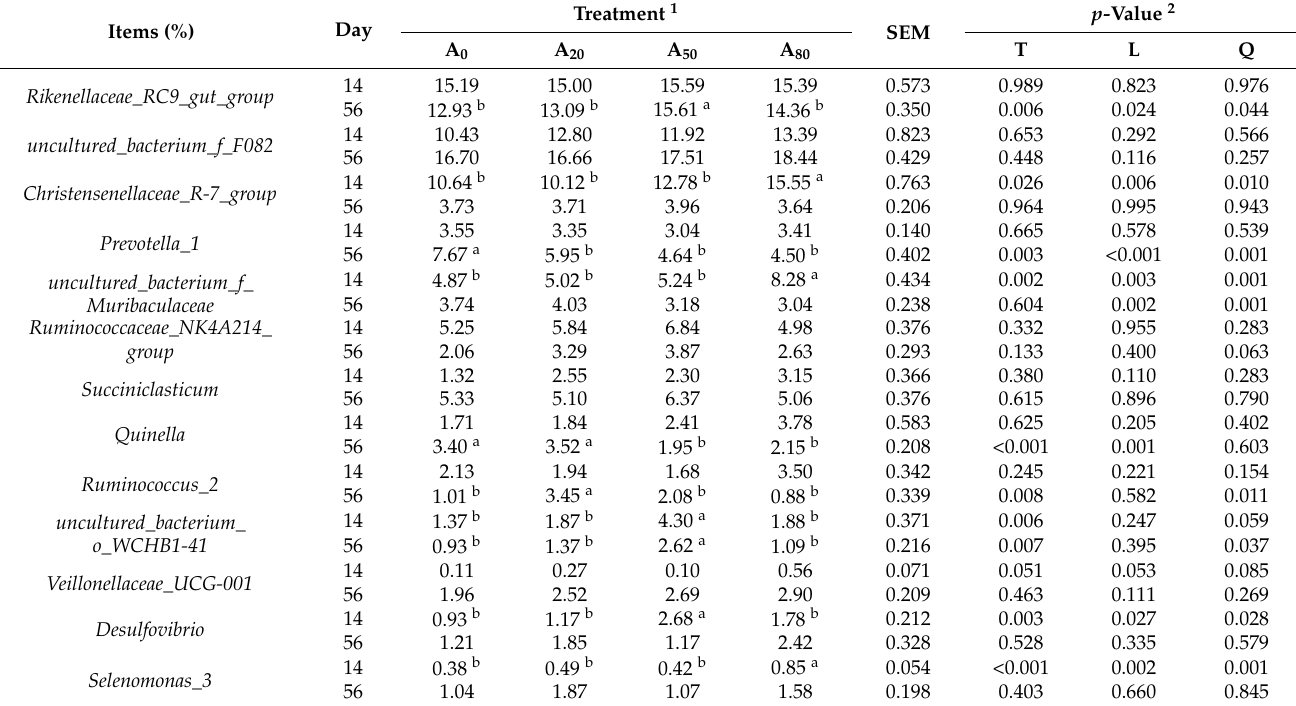
Table 4. The effect of supplementary Astralagus membranaceus (AMT) on rumen bacteria composition at the genus level of Tibetan sheep.